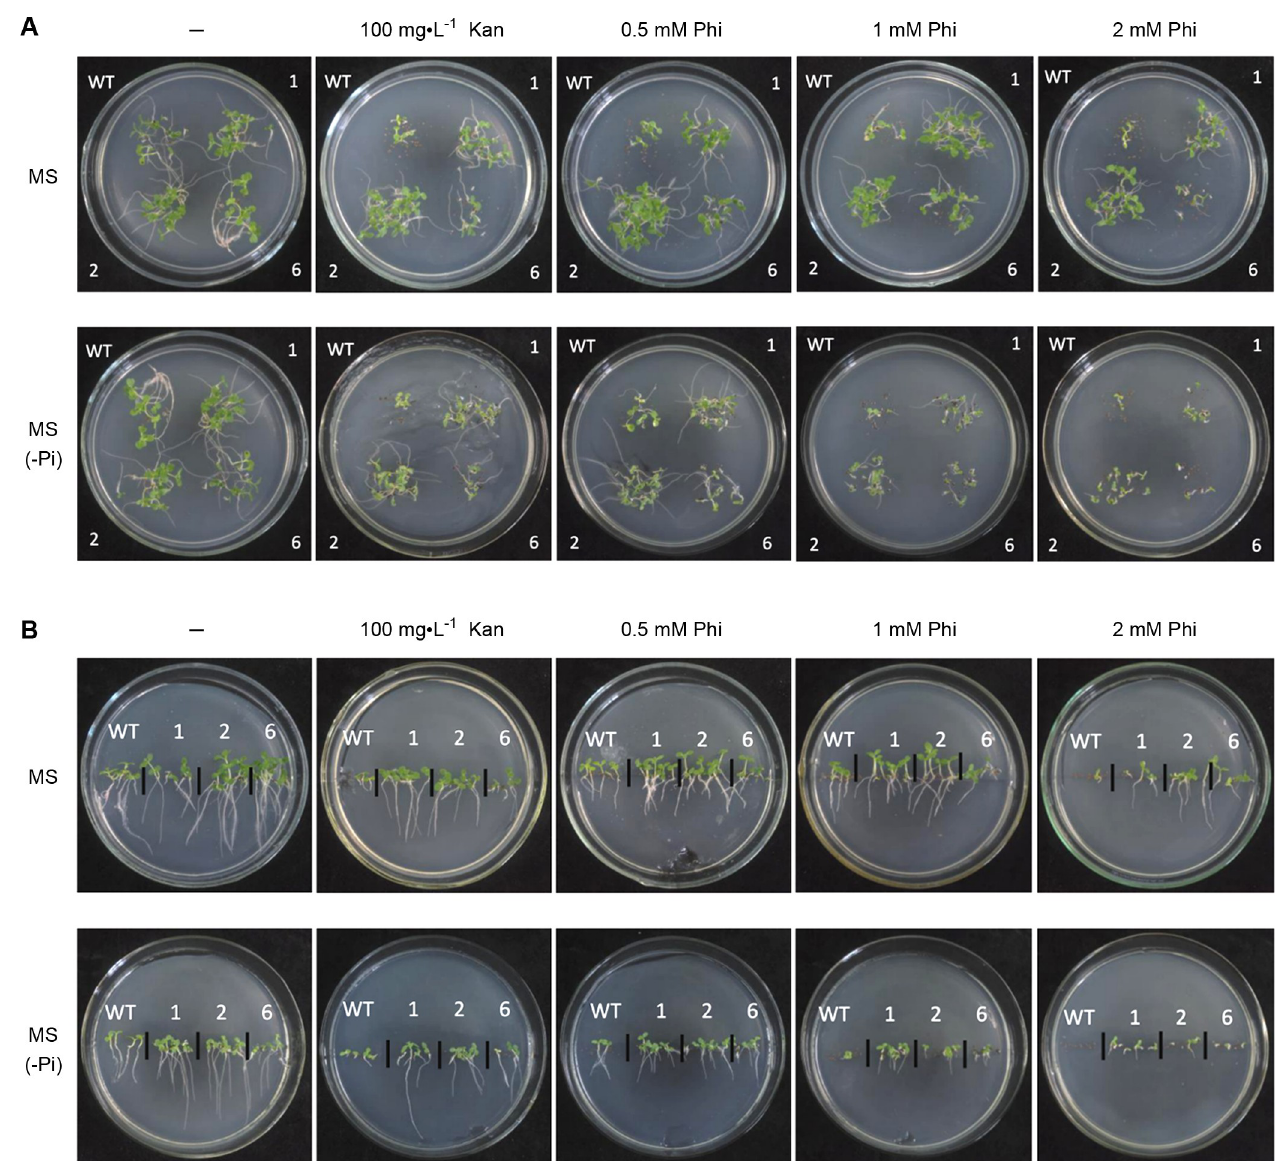
Fig 5. EcBAP(Phi) transgenic tobacco has an evident Phi-resistance, as evaluated by seed germination and seedling growth under Phi stress. The sterilized seeds of WT tobacco and EcBAP(Phi) transgenic lines (1, 2, 6) were sowed on standard MS or MS (-Pi) medium individually containing different concentrations (0.5, 1, 2 mM) of Phi as well as 100 mg � L -1 Kan. Their holding petri-dishes were placed (A) horizontally or (B) vertically in a plant growth chamber at normal cultivation conditions for 2 weeks, and then photo-recorded for comparison. https://doi.org/10.1371/journal.pone.0259600.g005 implemented two types of plate tests, i.e. placing the seed-sowed petri-dishes horizontally (Fig 5A) and vertically (Fig 5B). On standard MS medium with the stresses of 0.5, 1, 2 mM Phi, the seed germination and seedling growth were remarkably inhibited in WT tobacco with an apparent reduction in germination rate, stem height, root length and leaf green color, which became worse with increased concentration of Phi. Contrastively, this inhibition was less evi- dent in all three selected EcBAP(Phi) transgenic lines (1, 2, 6), despite with an exacerbating tendency under higher Phi stresses. On MS (-Pi) medium, the Phi-induced inhibition at each concentration on seed germination and seedling growth was more serious for either WT